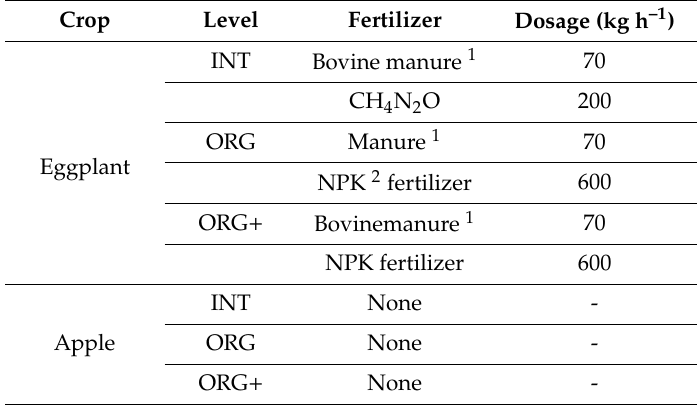
Table 2. Type and splitting of fertilizers for each fruit crop in the three cropping systems. Crop Level Fertilizer Dosage (kg h –1 )